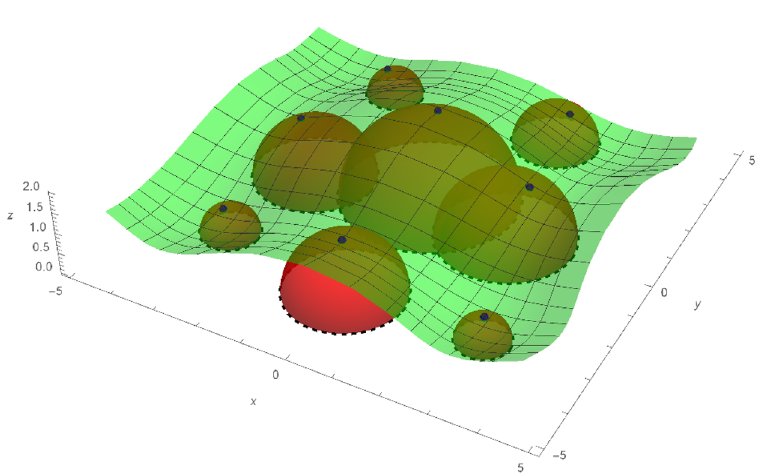
Figure 1 . The envelope (in green) of the extremal surfaces (in red) anchored to the family of balls (cid:1) (cid:0) R ( x 0 ; y 0 ) = 2 (cid:0) 1 p sin 2 ( x 0 = 2) + sin 2 ( y 0 = 2) in a spatial slice of empty AdS 4 . Poincar(cid:19)e coordinates 2 (de(cid:12)ned in (2.6)) are used, therefore the boundary of the spatial slice is at z = 0. The blue points highlight where the extremal surfaces depicted on the plot are tangent to envelope and the dashed lines are the boundaries of the balls to which the extremal surfaces are